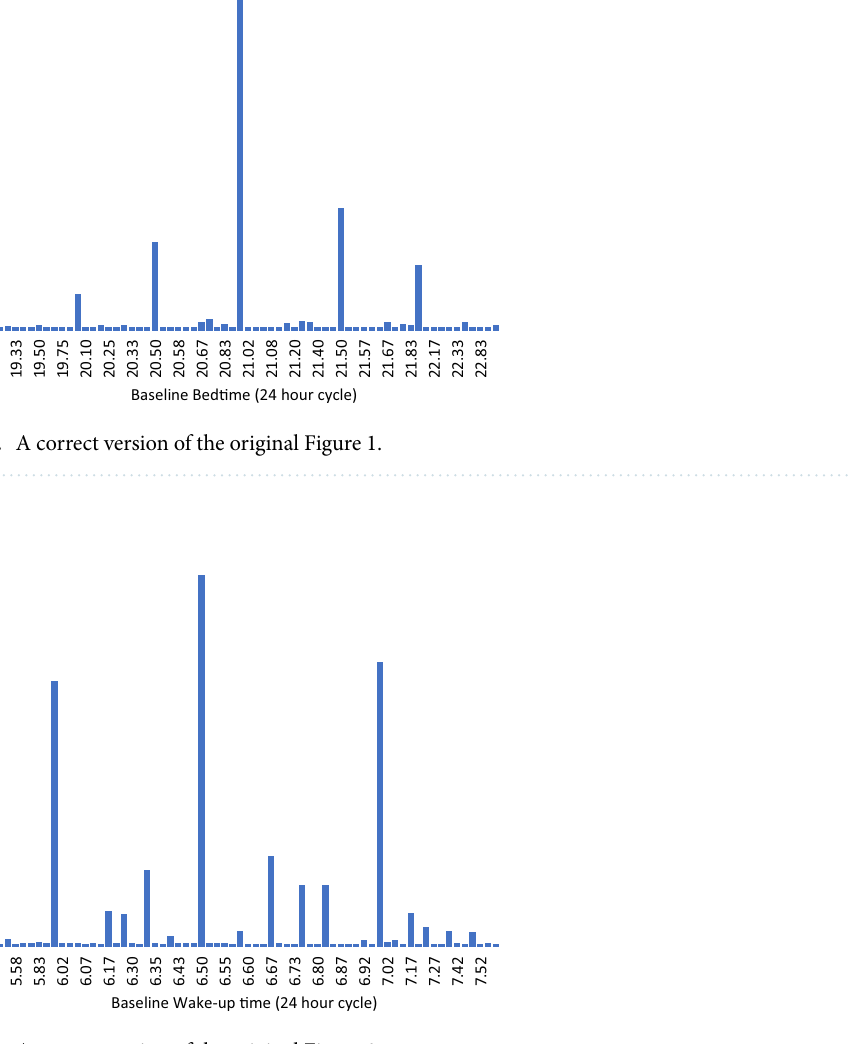
Figure 2. A correct version of the original Figure